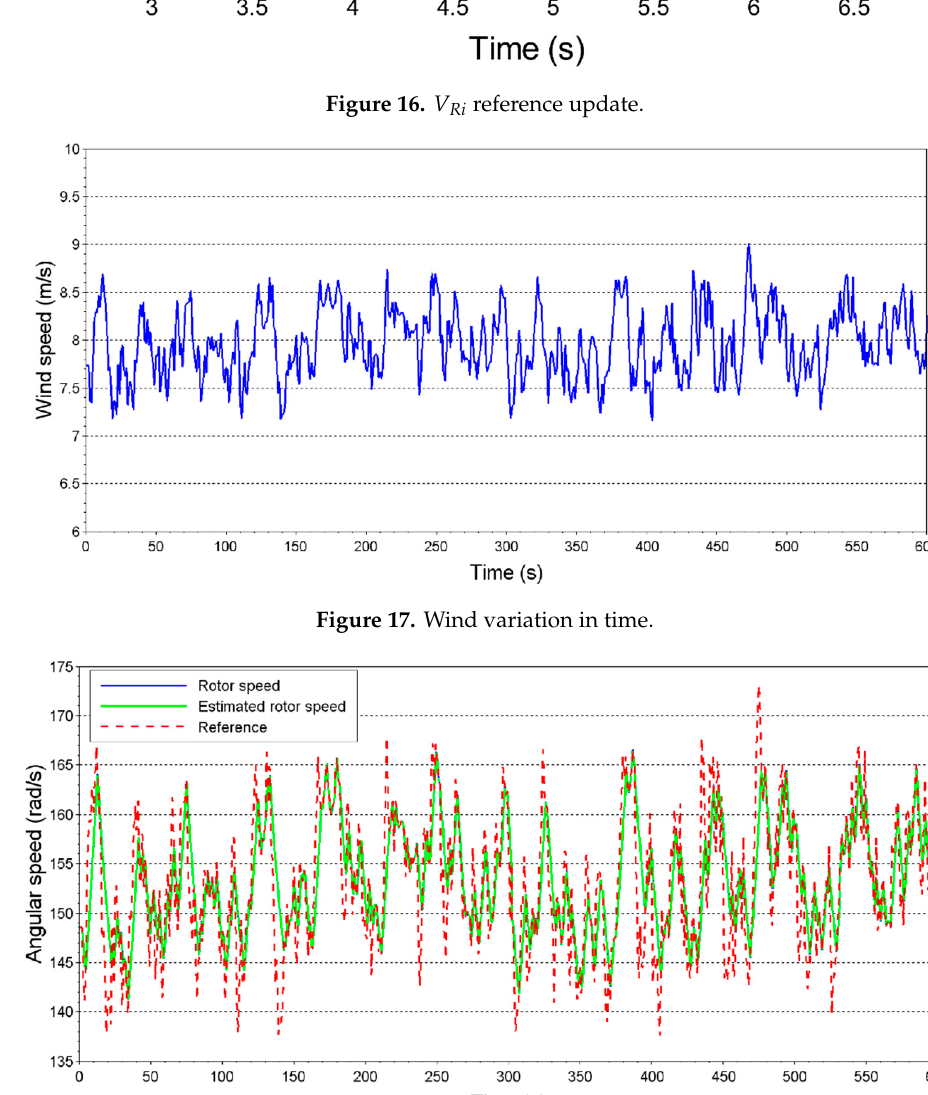
Figure 16. (cid:1848) (cid:3019)(cid:3036) reference update.